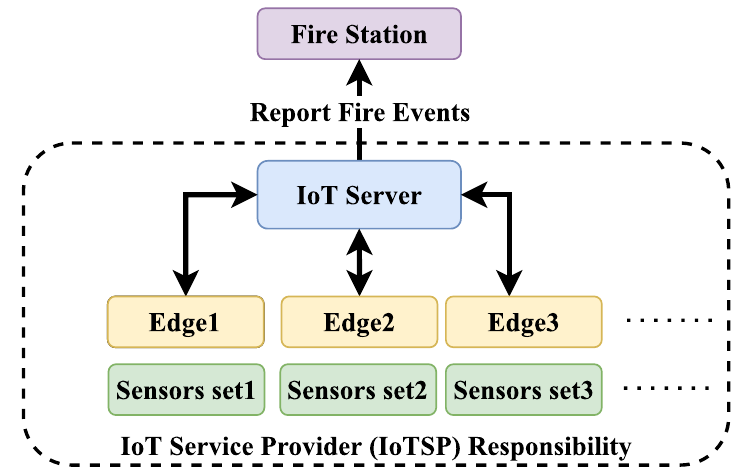
Fig. 2 Overview of an IoT-based Fire Mitigation System. Edges 1,2, and 3 represent the edge computing nodes